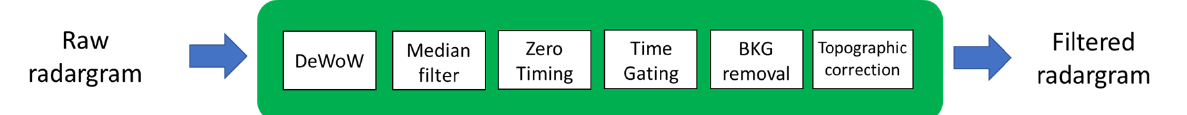
Figure 10. The flowchart shows GPR data processing steps.